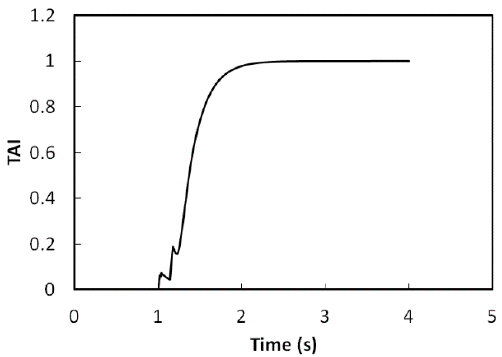
Figure 20. The TAI with middle level control.